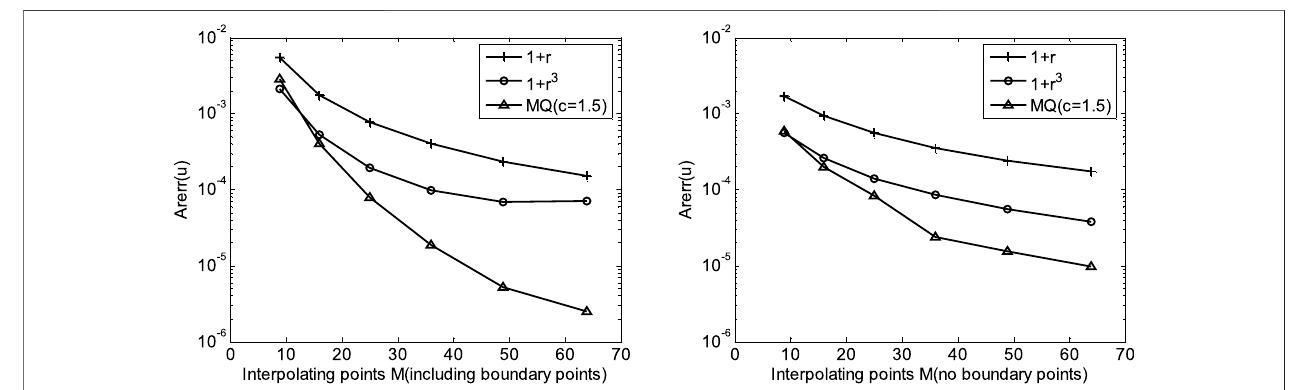
FIGURE 6 | Convergence curves of average relative error for nonlinear Burger ’ s problems with N = 24 by using different interpolation schemes.